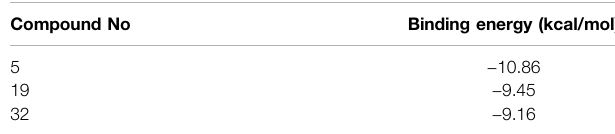
TABLE 1 | Binding energy of the identi fi ed